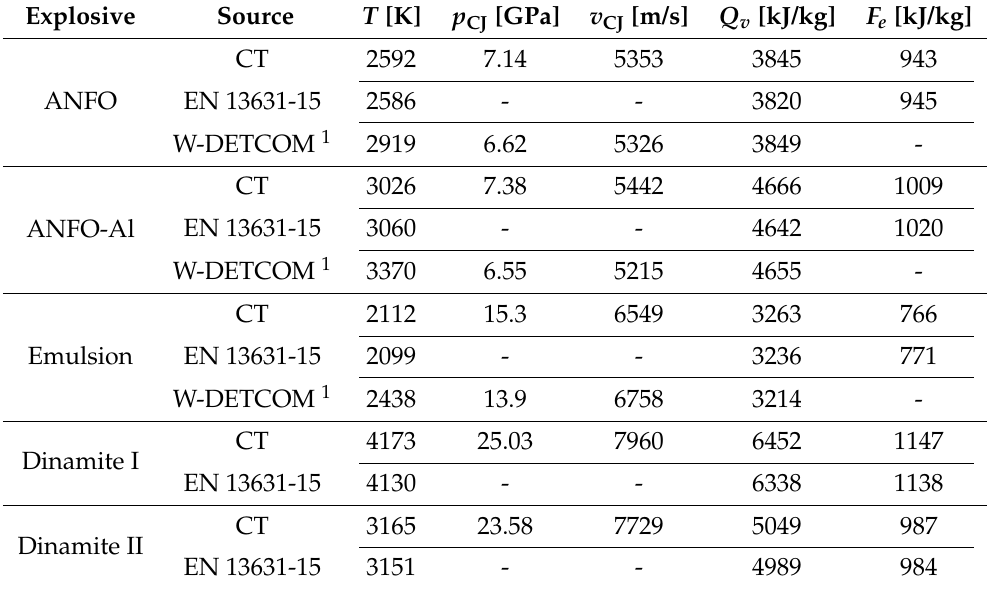
Table 1. Comparison of the calculated temperature at constant volume, T , detonation pressure, p CJ , detonation velocity, v CJ , heat release at constant volume, Q v , and explosive force, F e , with the results provided by the European Standard EN 13631-15 [43] and by the thermochemical code W-DETCOM [49] for different explosive mixtures using the BKW–S EoS.